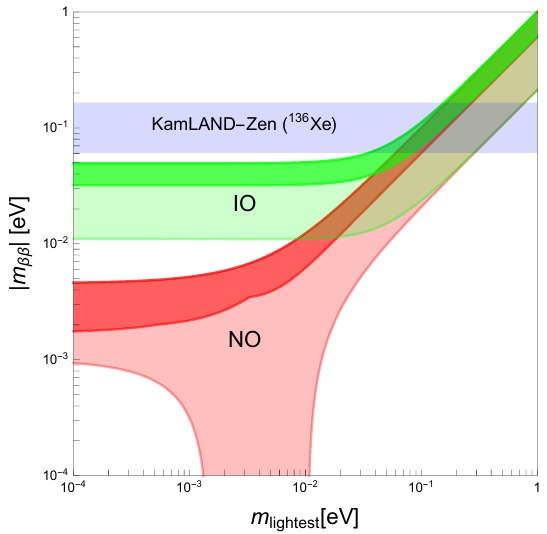
m (cid:12)(cid:12) as a function of the lightest active j j